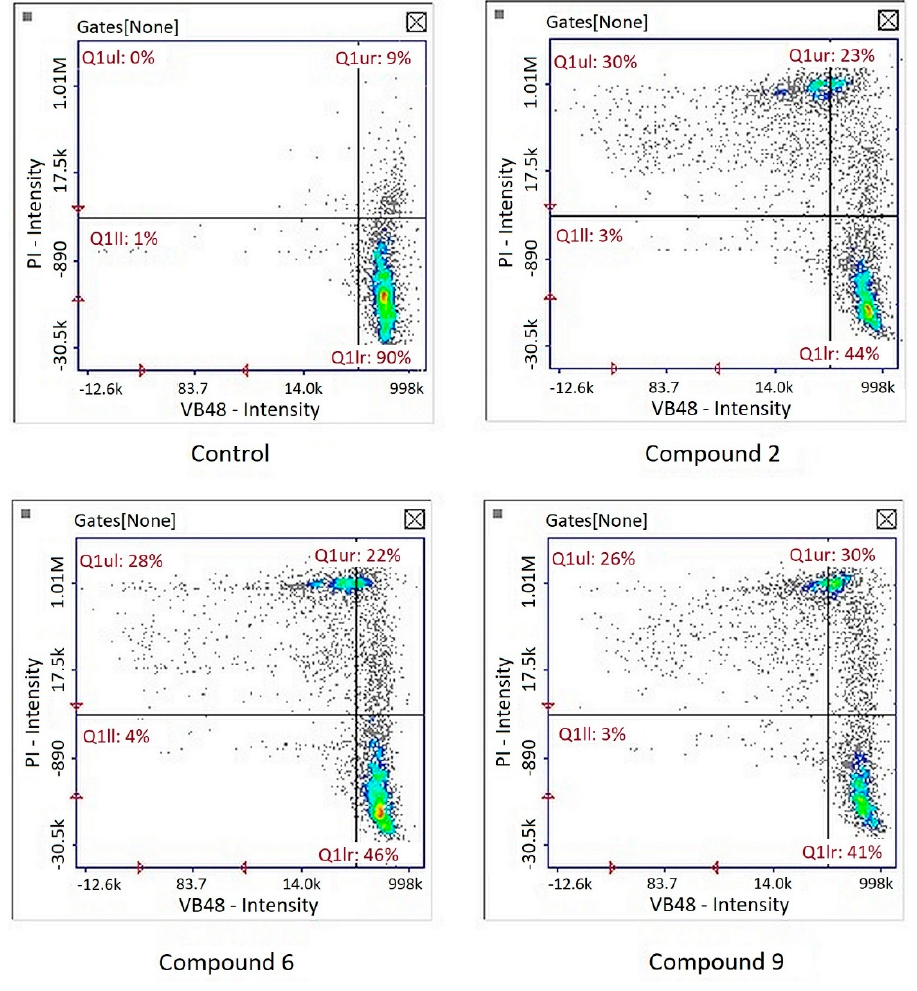
Figure 7. Representative histograms of reduced glutathione (GSH) content analysis in cultures of melanoma line G-361 after 24 h treatment with compounds PK2, PK6 and PK9 in concentrations corresponding to appropriate IC 50 values or DMSO as a vehicle in control culture using image cytometry. Table 5. Relative mRNA expression level of selected genes. The results were calculated as RQ values and are presented as the mean ± SD value of three independent experiments. Significantly changed median RQ levels are marked with a color